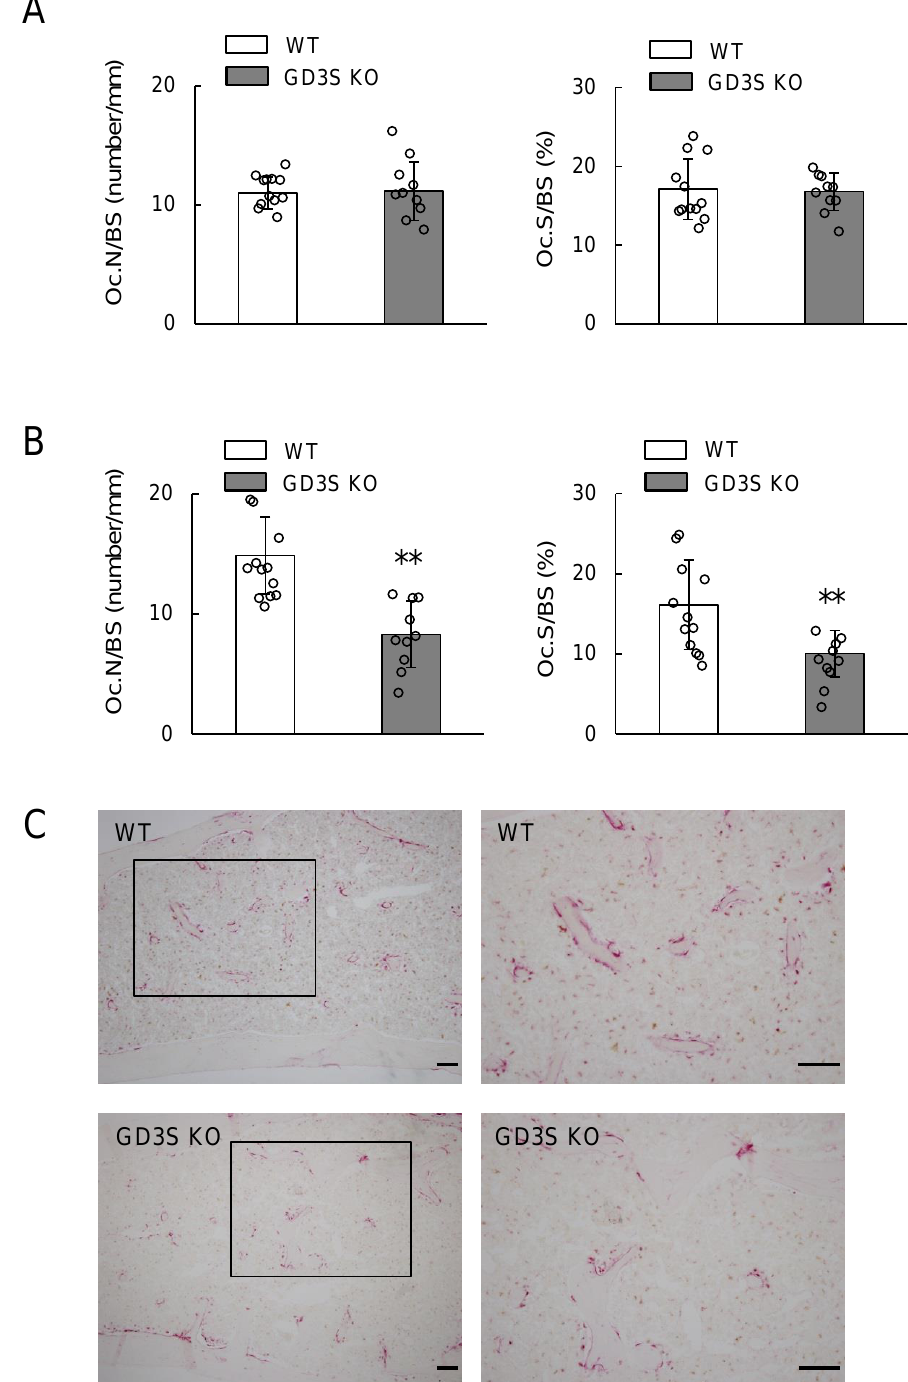
Figure 6. Decrease in bone resorption parameters by GD3 synthase deficiency in vivo. ( A ) 15-week-old mice (male, n = 12 for WT, n = 10 for GD3S KO). ( B ) 40-week-old mice (male, n = 12 for WT, n = 10 for GD3S KO). Osteoclast numbers / bone surface (Oc.N / BS, number / mm), and osteoclast surface / bone surface (Oc.S / BS, %) are presented. ( C ) Images of tartrate-resistant acid phosphatase (TRAP) staining of femoral cancellous bone. Results for WT mice (upper) and GD3S KO mice (lower) are shown. Right images are higher magnifications of the boxed areas in the images on the left. The scale bars are 100 µ m. Data are expressed as mean ± SD. The double asterisks (**) indicate p <